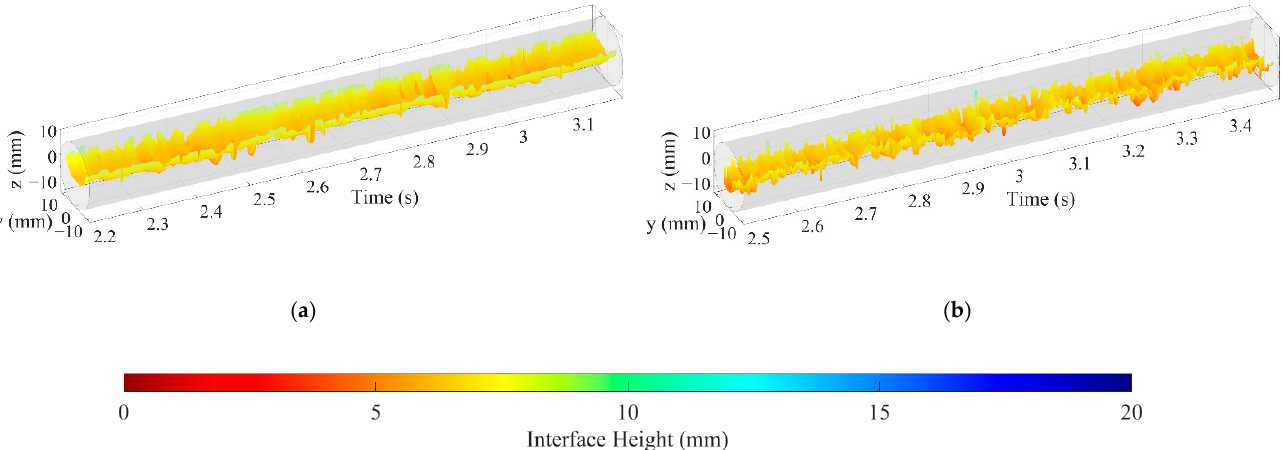
Figure 16. Extraction process of 2D oil–water interface: ( a ) Interpolation matrix V ip ( k ); ( b ) Binarization processes ( V th ( k )); ( c ) Remove dispersed droplets ( V inf ( k )); ( d ) Interface extraction using watershed algorithm.